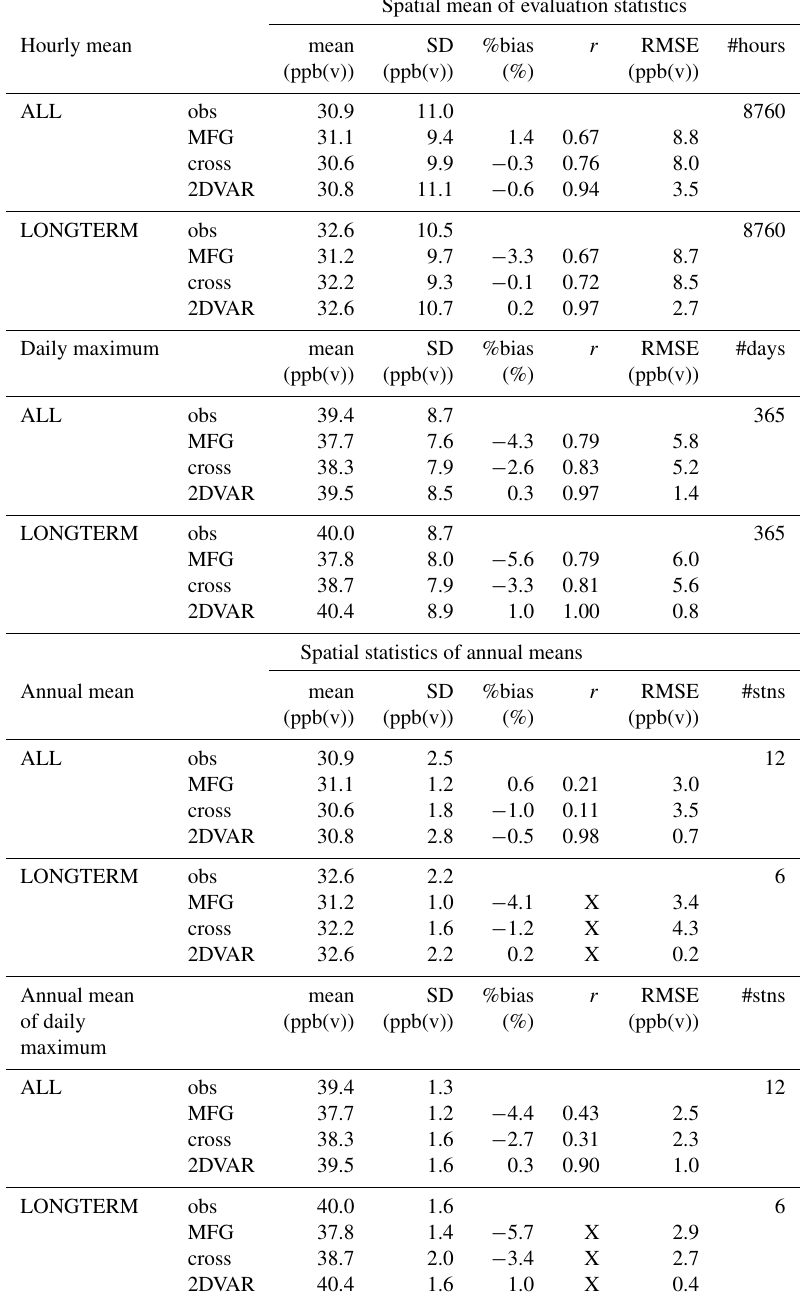
Table 2. Evaluation of modeled hourly and daily maximum of 1h mean near-surface ozone concentrations in 2013 at Swedish observation sites. Mean value (mean), standard deviation ( σ ), model mean bias normalized by the observed mean (%bias), Pearson correlation coefficients ( r ) for data including at least 10 pairs, the root mean square error (RMSE) and number of observed hours/days ∗ at the sites. The evaluation includes the reanalyzed data sets ALL and LONGTERM, where ALL is evaluated at the 12 Swedish sites included in that simulation, and LONGTERM is evaluated at the 6 Swedish sites included in that simulation (see Fig. 4). For each of these data set evaluations we include the observation- dependent reanalysis (2DVAR), the observation- independent cross validation of the reanalysis (cross) and the MATCH base case simulation (MFG). The top half of the table shows the temporal performance (spatial mean of evaluation statistics; see Supplement Sect. S1). The bottom half of the table shows spatial performance (spatial statistics of annual means; see Sect.